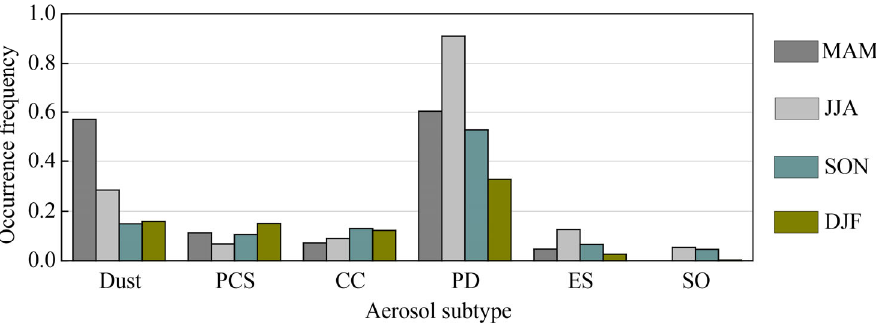
Figure 4. Seasonal occurrence frequency of aerosol subtypes for years 2007 to 2021. (PCS: polluted continental/smoke; CC: clean continental; PD: polluted dust; ES: elevated smoke; SO: sulfate/other).